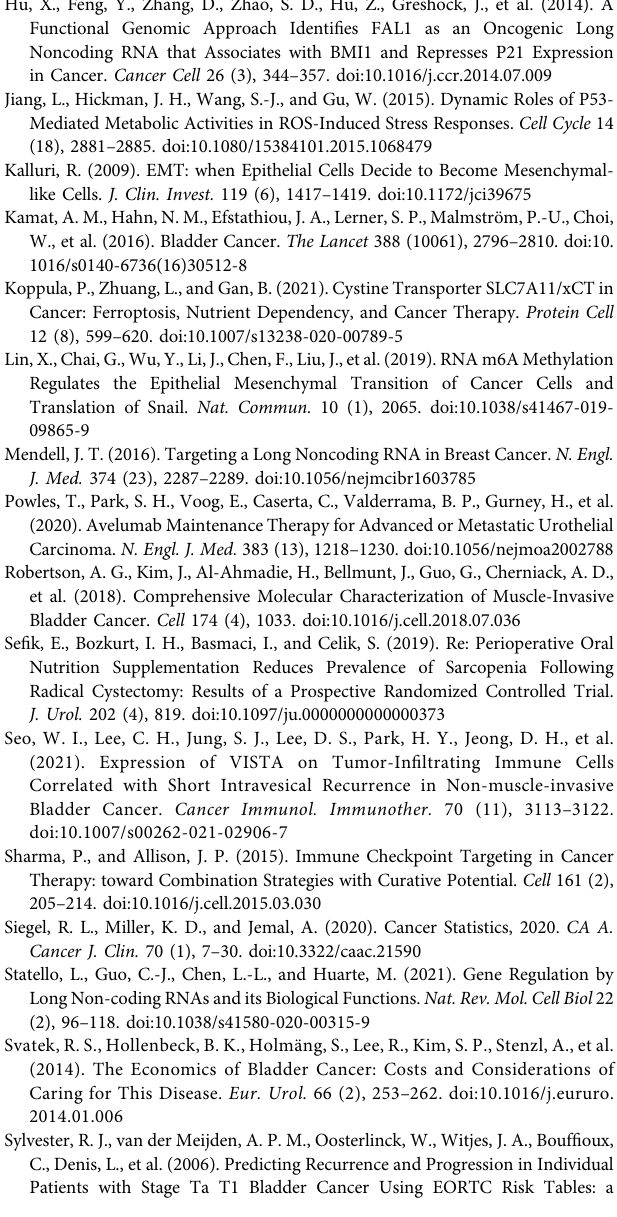
Supplementary Figure S2 | Validation of prediction model in testing set. (A) Kaplan – Meier survival curves. (B) Receiver operating characteristic (ROC). Distribution of risk scores (C) and survival status (D) . (E) Expression heatmaps of the fi ve ferroptosis-prognosis – related lncRNAs. Supplementary Figure S3 | Validation of prediction model in entire set. (A) Kaplan – Meier survival curves. (B) Receiver operating characteristic (ROC). Distribution of risk scores (C) and survival status (D) . (E) Expression heatmaps of the fi ve ferroptosis-prognosis – related lncRNAs. SupplementaryFigureS4| Identi fi cation ofprognosticindicatorsintestingset. (A) Univariate Cox regression analysis. (B) Multivariate Cox regression analysis. (C) ROC curve of prognostic indicators for bladder cancer. (D) Time-dependent ROC curve of the risk score. Supplementary Figure S5 | Identi fi cation of prognostic indicators in entire set. (A) Univariate Cox regression analysis. (B) Multivariate Cox regression analysis.